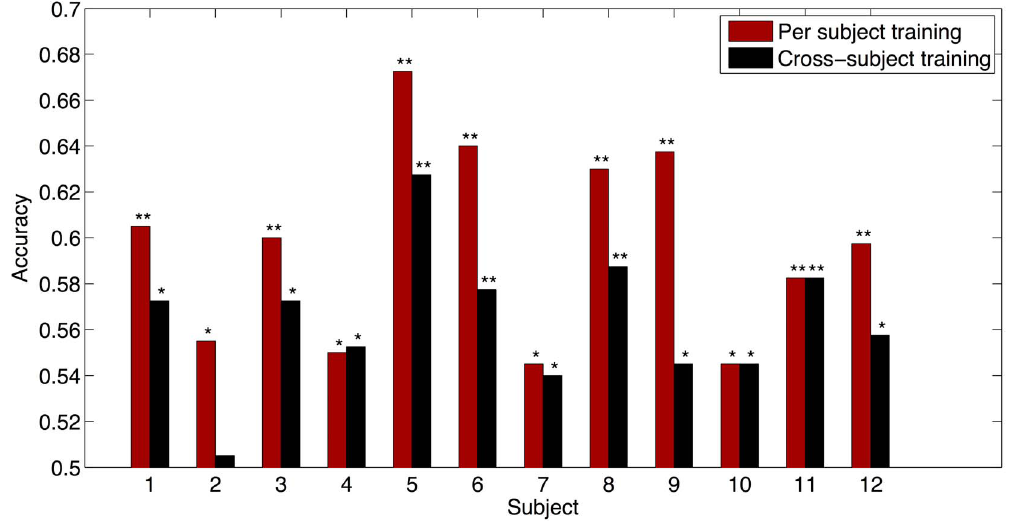
Figure 4. Classification accuracies for the individually trained classifier and the classifier trained across subjects. Accuracies are mean accuracies of test set performance over ten folds. (* 0.001 , p , 0.05, **p , 0.001).